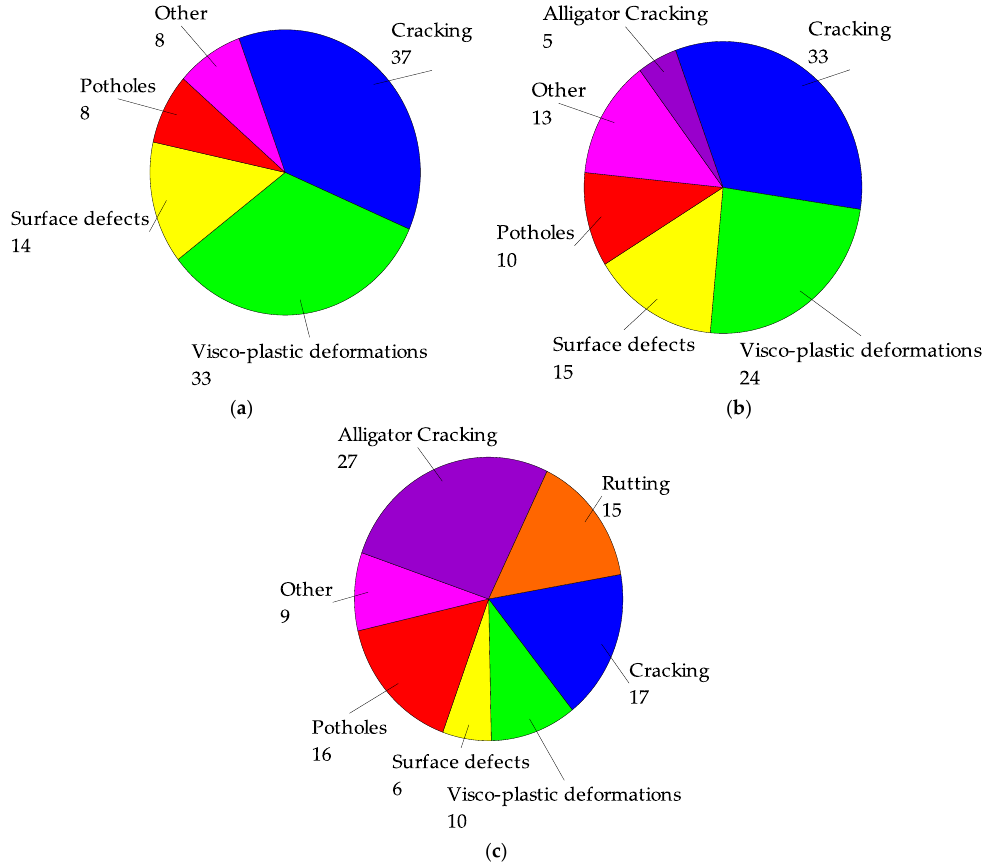
Figure 3. Road pavement observed distresses distribution by Pavement Condition Index (PCI) condition in urban areas. Percentage of observed distress in: ( a ) Adequate PCI sections; ( b ) Medium PCI sections; ( c ) Unsatisfactory PCI sections.